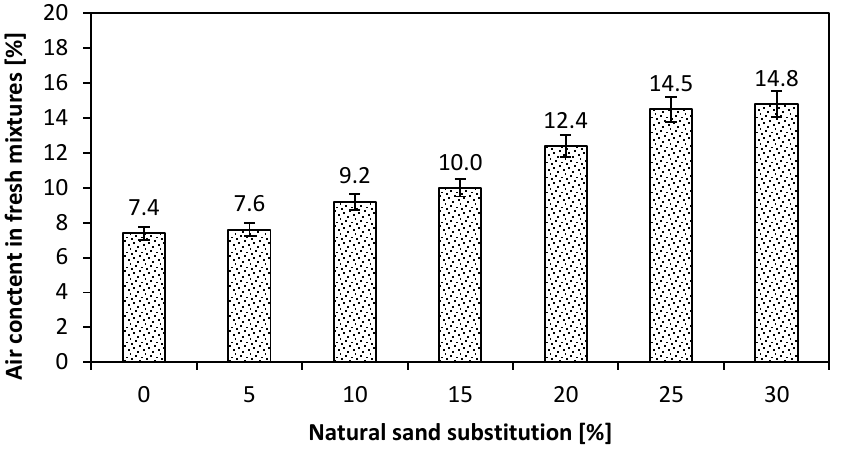
Figure 4. Content of air in fresh mixtures.